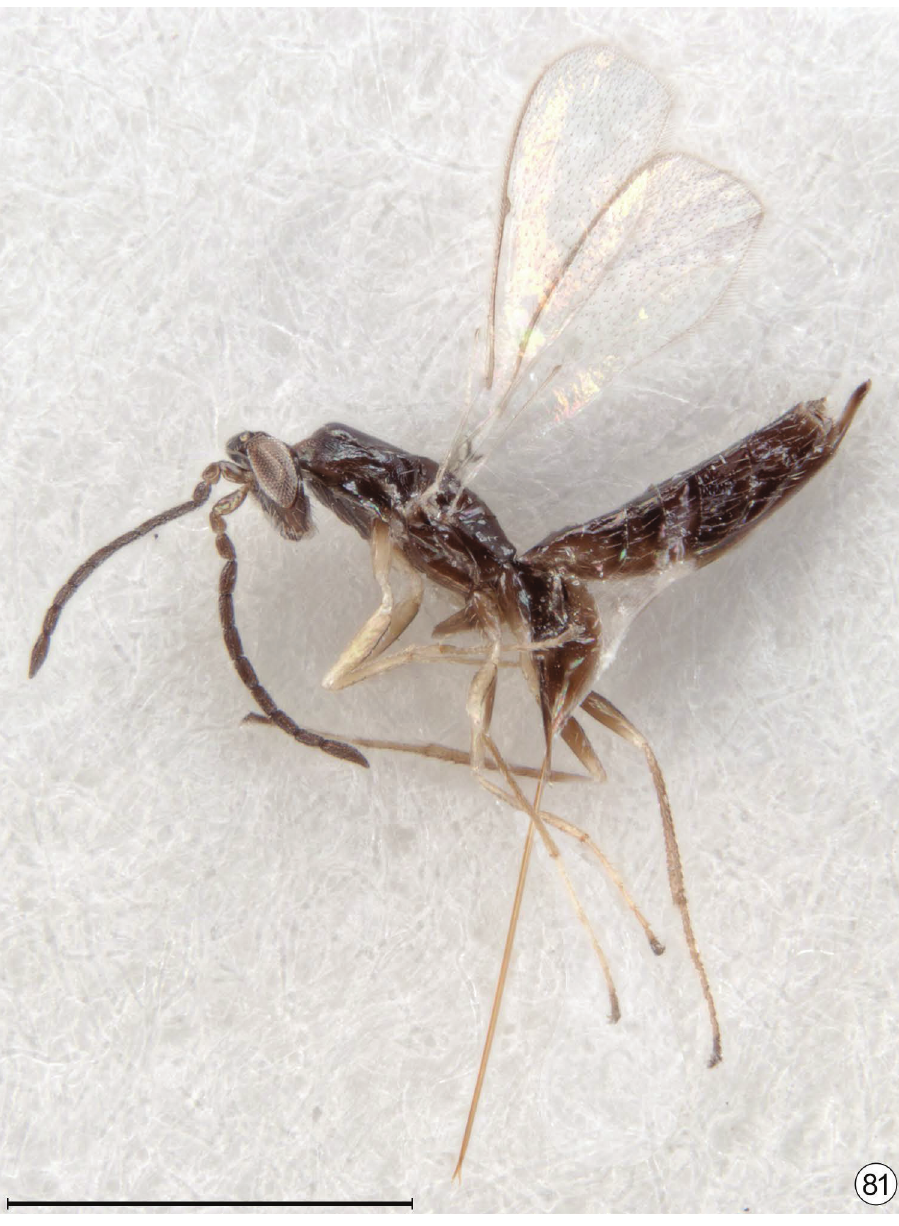
Figure 81. Neotriadomerus darlingi , paratype female, habitus lateral (35 km N. Renmark, 263 m, 11–14. ii.2000). Scale bar = 1000